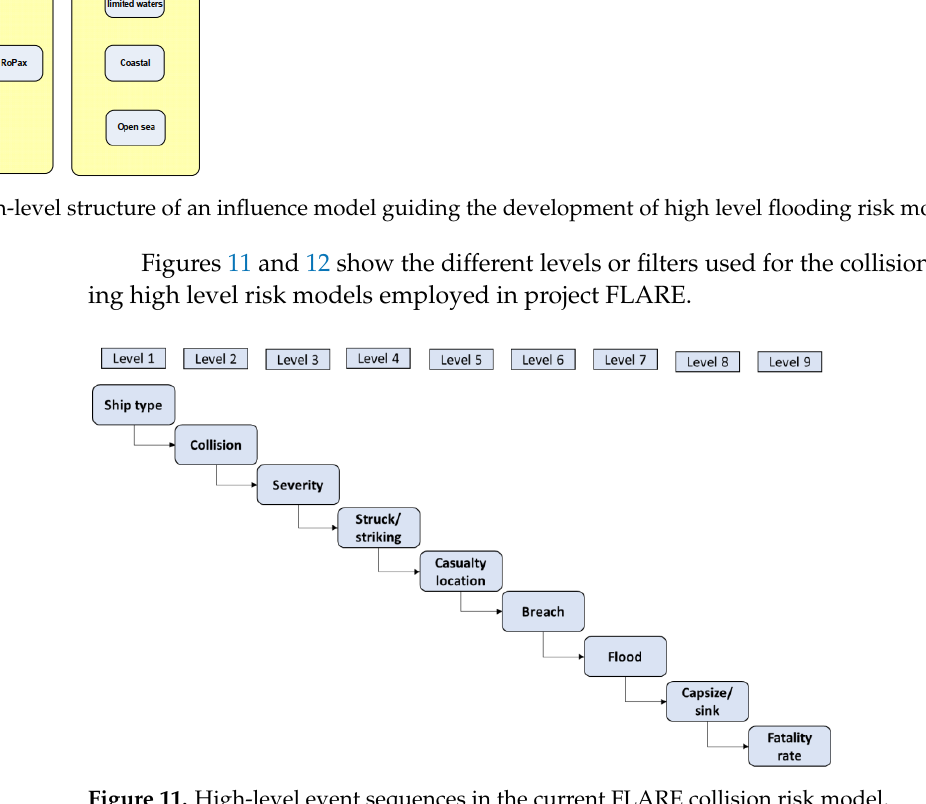
Figure 11. High-level event sequences in the current FLARE collision risk model.